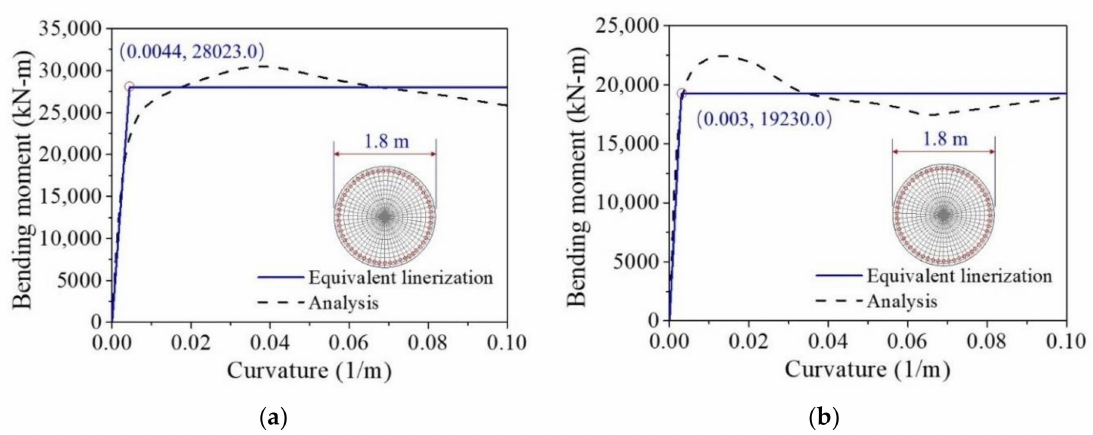
Figure 14. Sectional analyses of bending moment vs. curvature. ( a ) RC; ( b ) ECC.